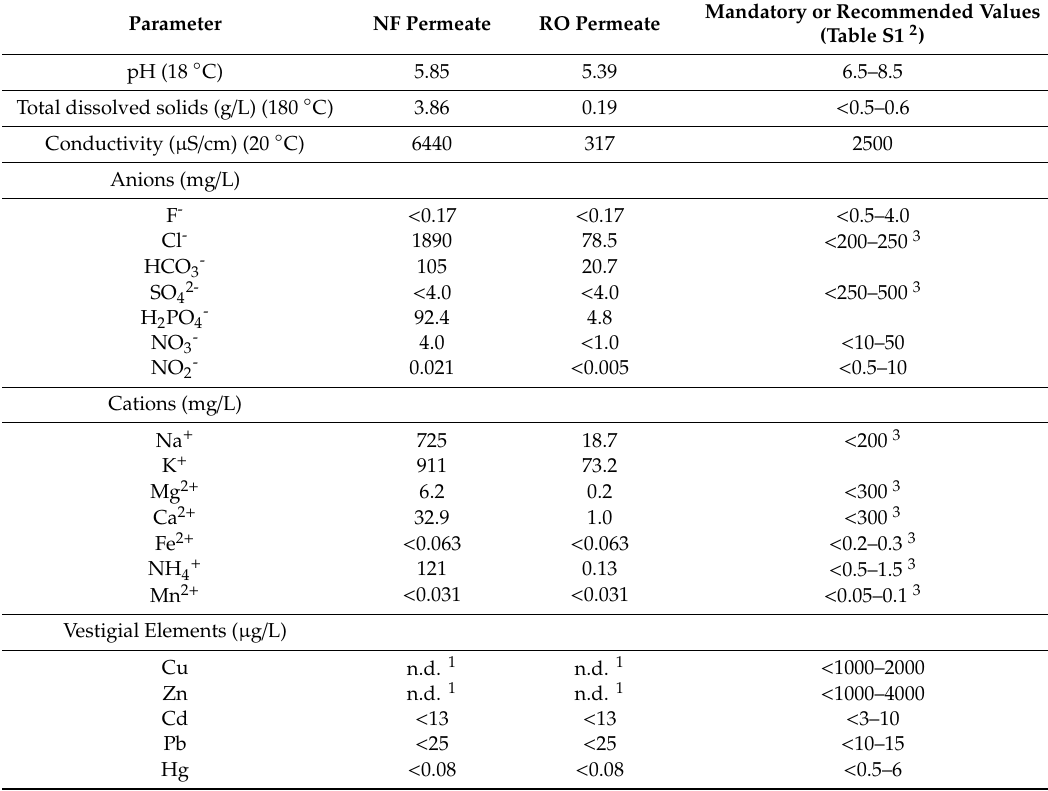
Table 2. Comparison of the nanofiltration (NF) and reverse osmosis (RO) permeates’ properties and composition against current recommendations and regulations for drinking